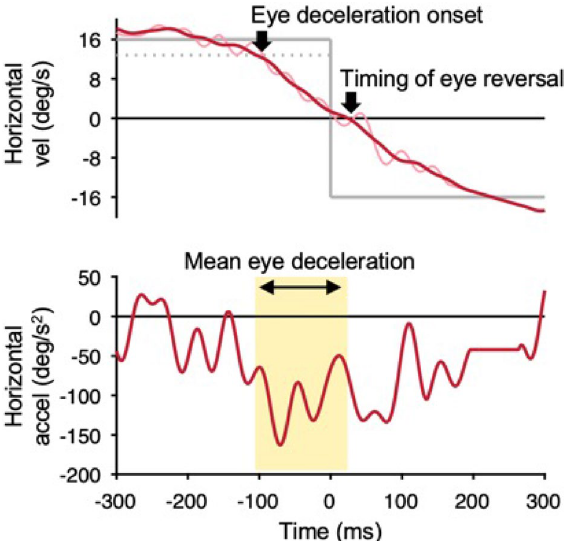
Figure 2. Eye velocity in a representative trial when the target speed was 16 deg/s. The top panel shows the eye velocity after filtering (30 Hz low-pass filter, light red line), the eye velocity with moving average applied to it (40-ms window, dark red line), and the target velocity (gray solid line). The threshold to detect the onset of predictive pursuit is represented by a gray dotted line. The bottom panel shows eye acceleration in the same trial. The yellow shaded region represents the time that the mean eye deceleration was calculated (i.e., the time between the eye deceleration onset and timing of eye reversal). The time of 0 ms represents the timing of target reversal. Upward deflections show rightward eye